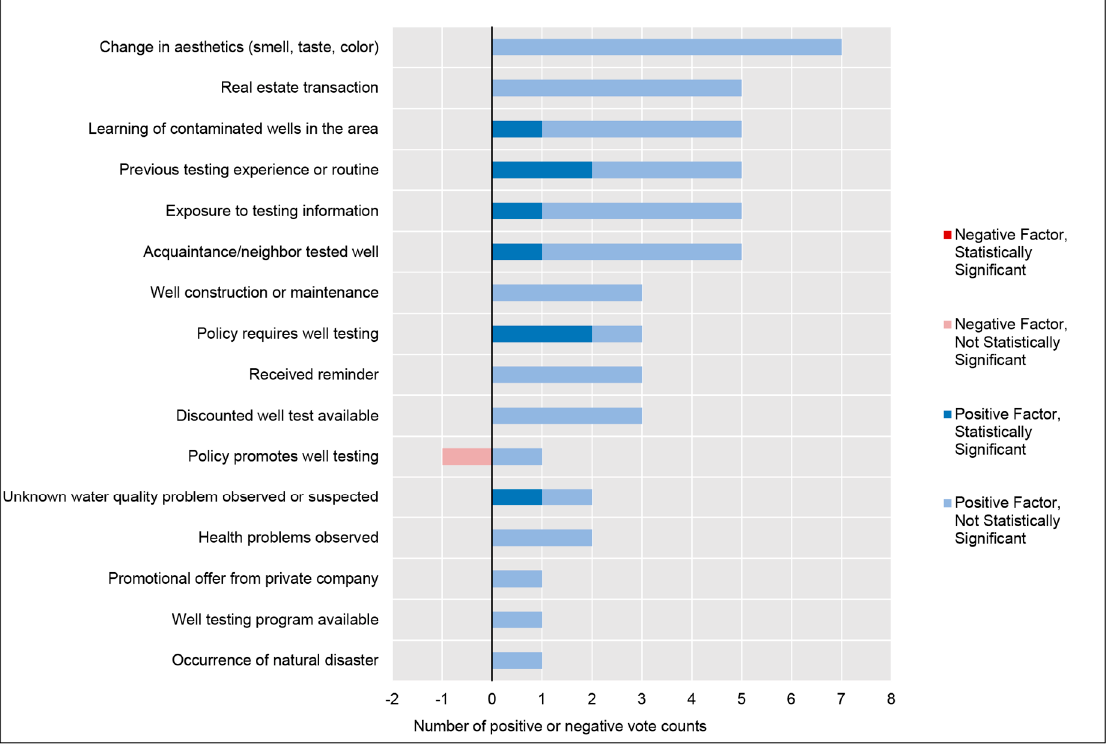
Figure 5. Counts and associations of cues to action identified in the literature. Cues to action are internal or external events or phenomena that can trigger action. Factors are presented in order from the most prevalent to least prevalent in the literature.